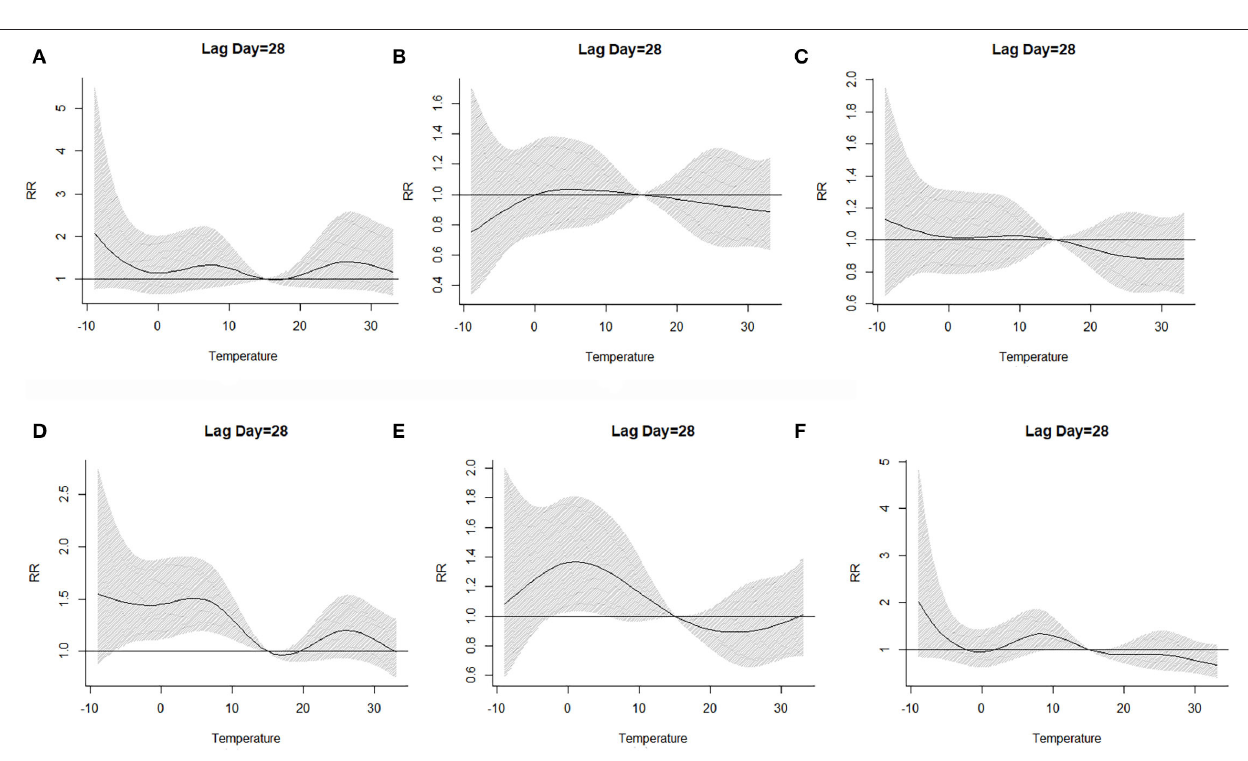
Frontiers in Medicine |